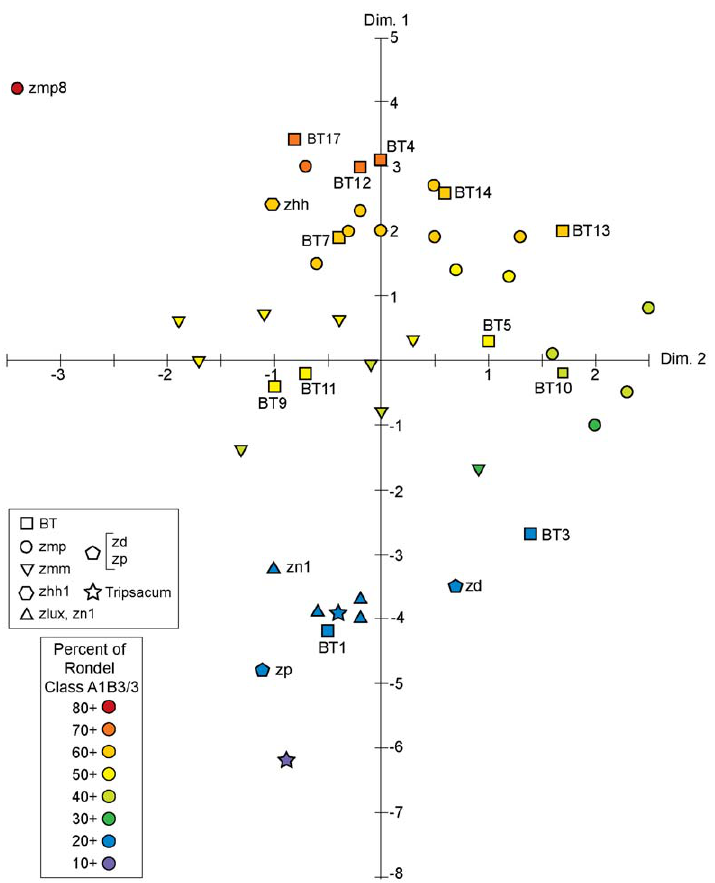
Figure 4. MDS results of Figure 2, coded for abundance of rondel class A1B3/3. Samples coded for teosinte taxa.